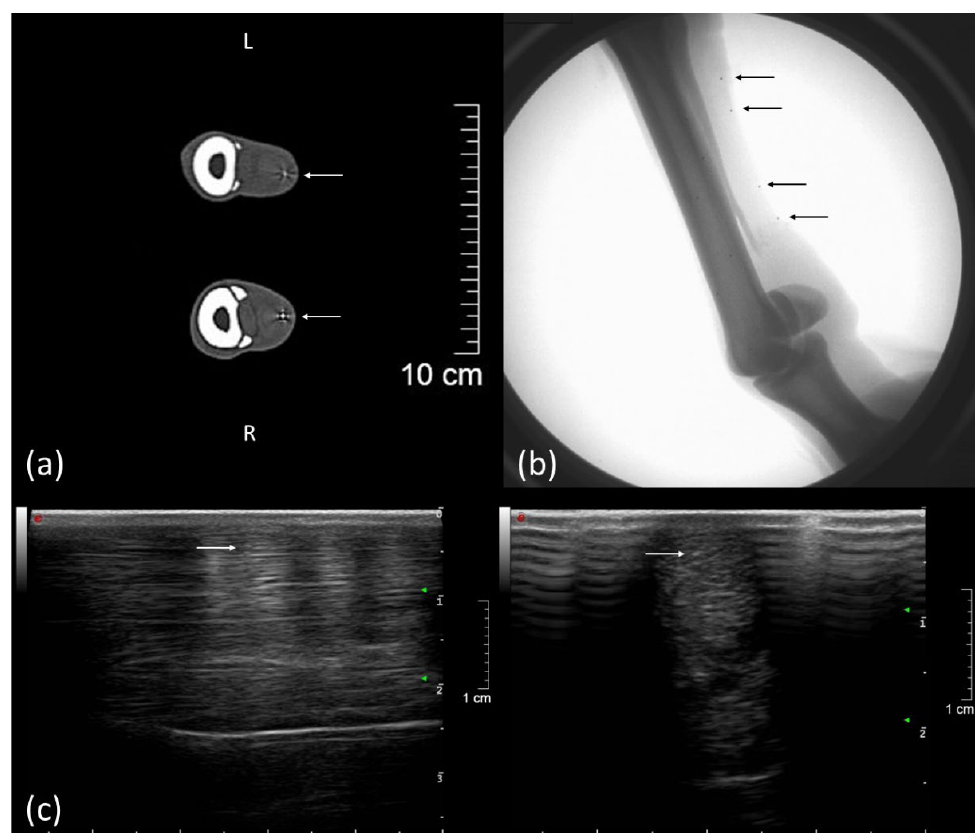
Figure 2. Computed tomography (CT), FluoKin, and ultrasonographic images of the left forelimb of a pony with implanted tantalum beads. ( a ) Two tendon markers with metal streak artifact in the CT image, left is dorsal; ( b ) FluoKin image of the distal forelimb with four tendon markers in the SDFT and five bone markers in the third metacarpal bone; ( c ) longitudinal and transversal ultrasound image with acoustic shadowing and reverberation artifact due to the implanted beads, left is distal. Arrows mark the implanted beads.